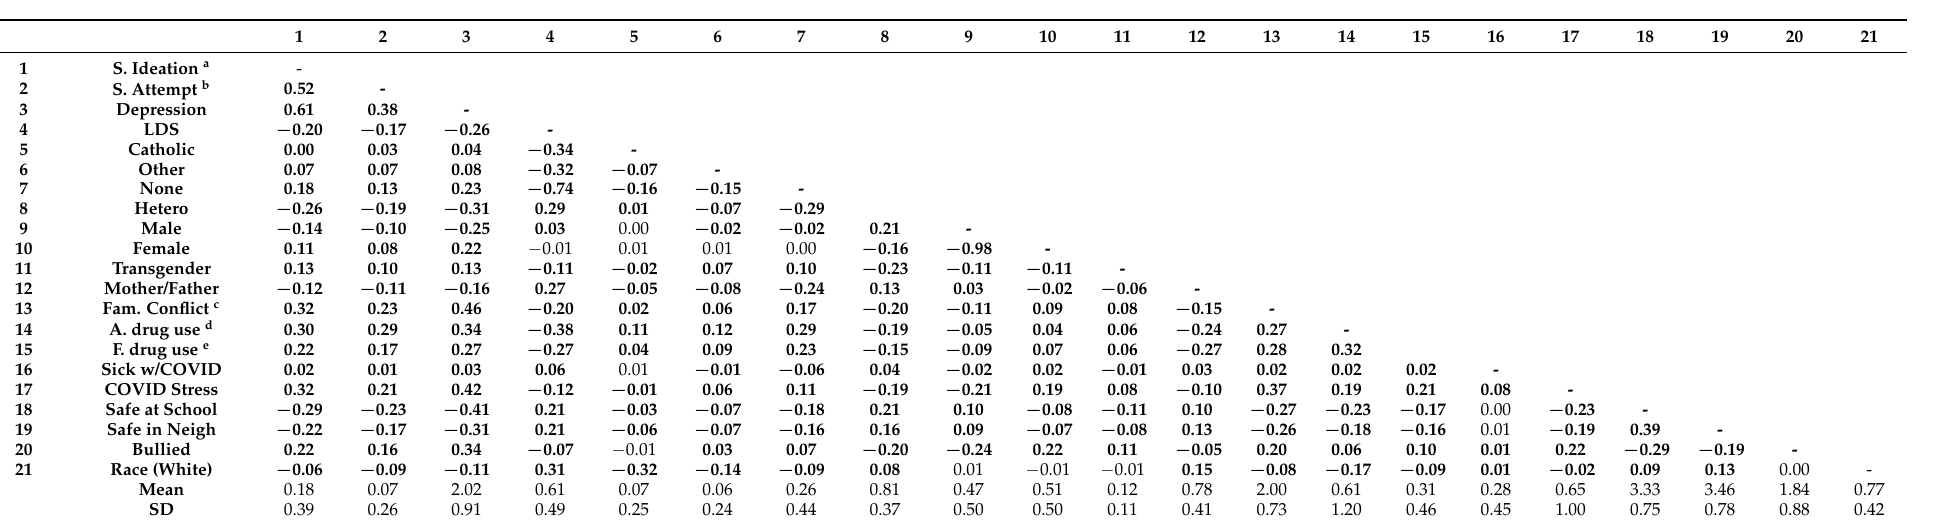
Table 1. Correlations, means, and standard deviations (n =